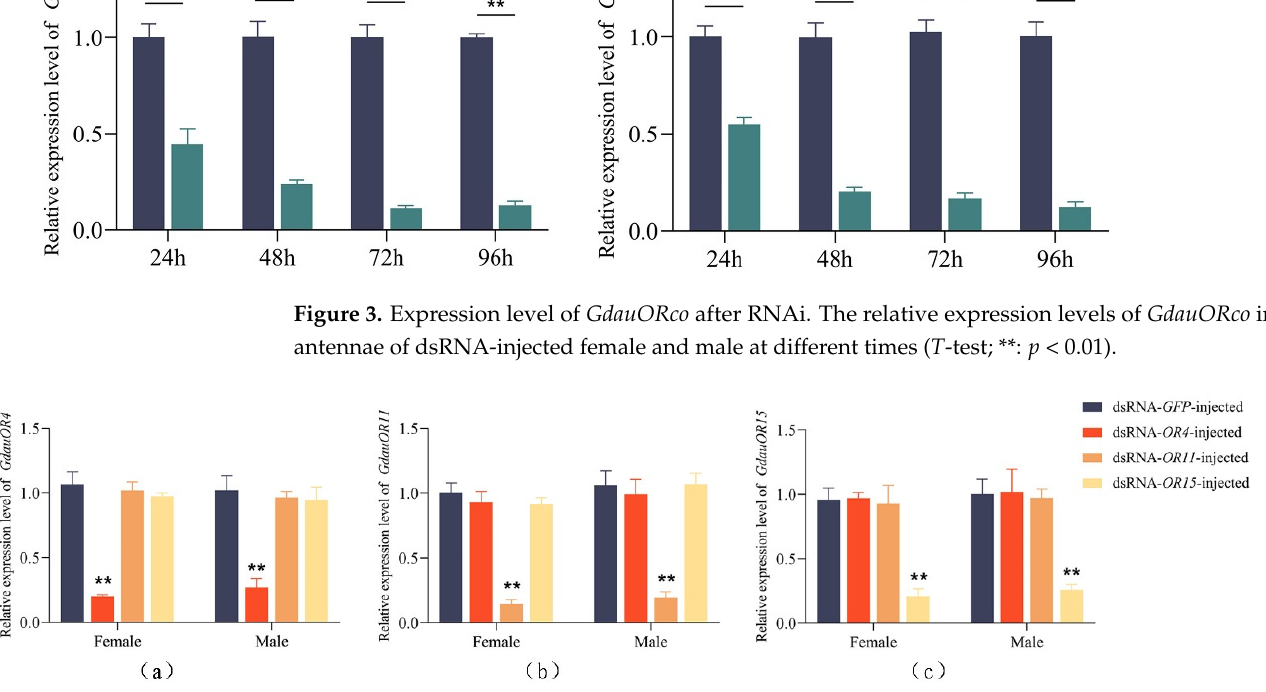
Figure 4. Expression level of GdauOR4 ( a ), GdauOR11 ( b ) and GdauOR15 ( c ) after RNAi 48 h. Bars labeled with different letters are significantly different ( T -test; **: p < 0.01). Columns indicate the mean ± standard error of three independent experiments.